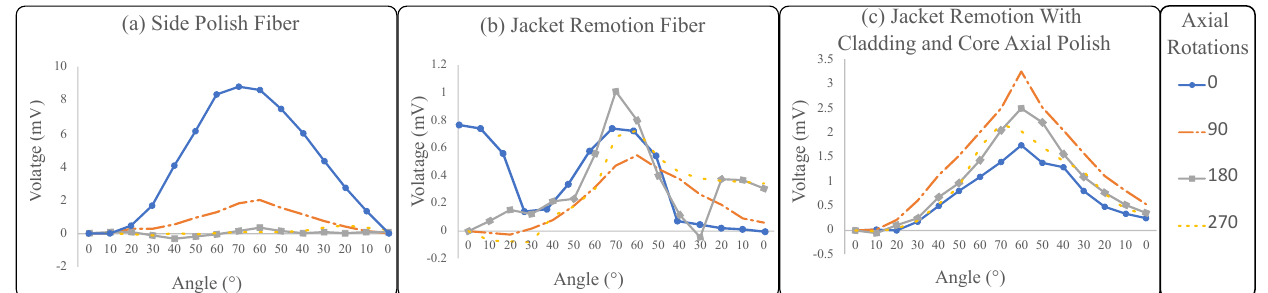
Figure 9. Results of the three sensor configurations per rotation: the dotted blue line corresponds to 0 ◦ , the dotted and dashed orange line corresponds to 90 ◦ , the squared gray line corresponds to 180 ◦ , and the dashed yellow line corresponds to 270 ◦ . ( a ) Side polish fiber. ( b ) Jacket remotion. ( c ) Jacket remotion with cladding and core axial